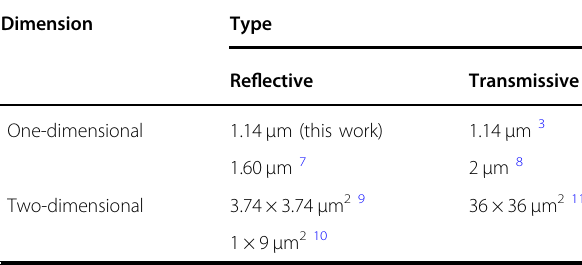
Table 1 Channel/pixel size of LC-based